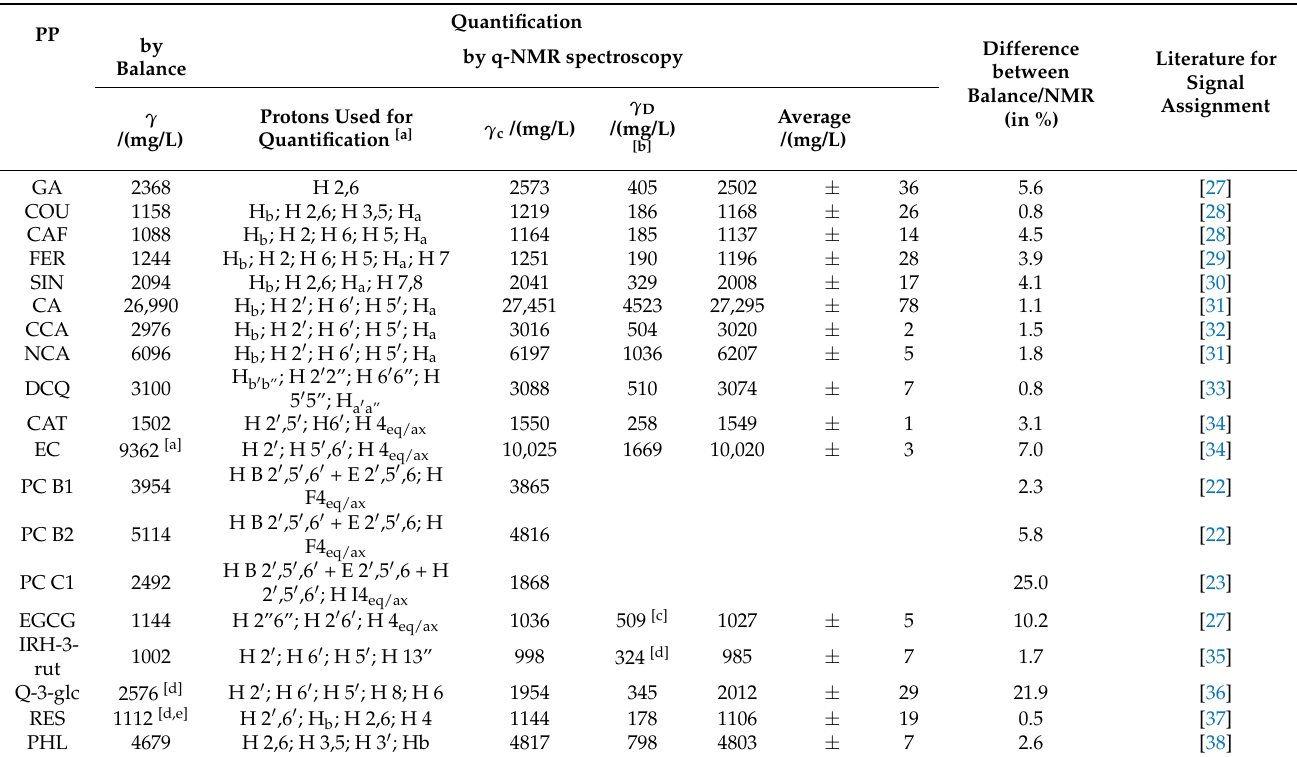
Table 4. Mass concentration γ of the phenolic solutions based on the weights and determined with q-NMR at two different